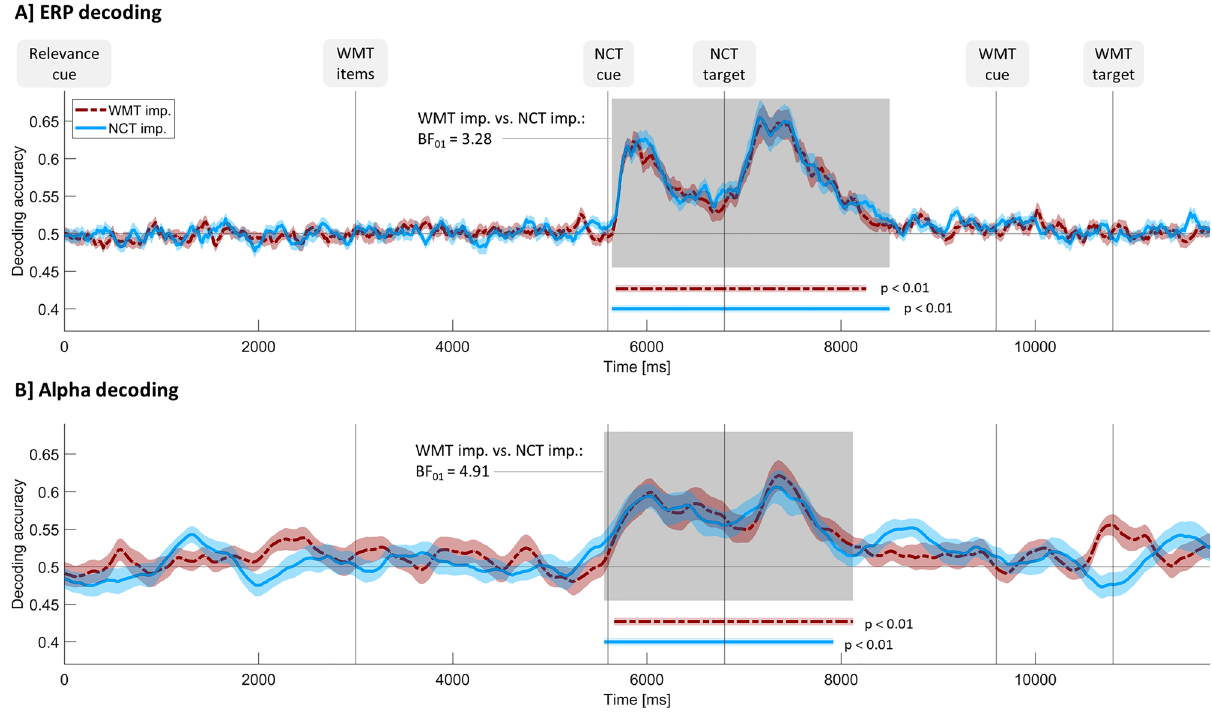
Figure 3. Decoding accuracies over time for ERP (panel A ) and alpha power (panel B ) for both experimental conditions separately. The horizontal line at 0.5 indicates chance level. Vertical lines indicate stimuli onset times. Shaded curve surroundings indicate between-subject standard error of the mean. Horizontal colored lines mark significant time points according to cluster-based permutation tests over time. The grey shading indicates time points where at least one experimental condition differs significantly from zero according to those tests. BF 01 reverse Bayes factor calculated for decoding accuracies averaged over the time points marked by the grey shading comparing WMT imp. and NCT imp., WMT working memory task, NCT number classification task, imp.